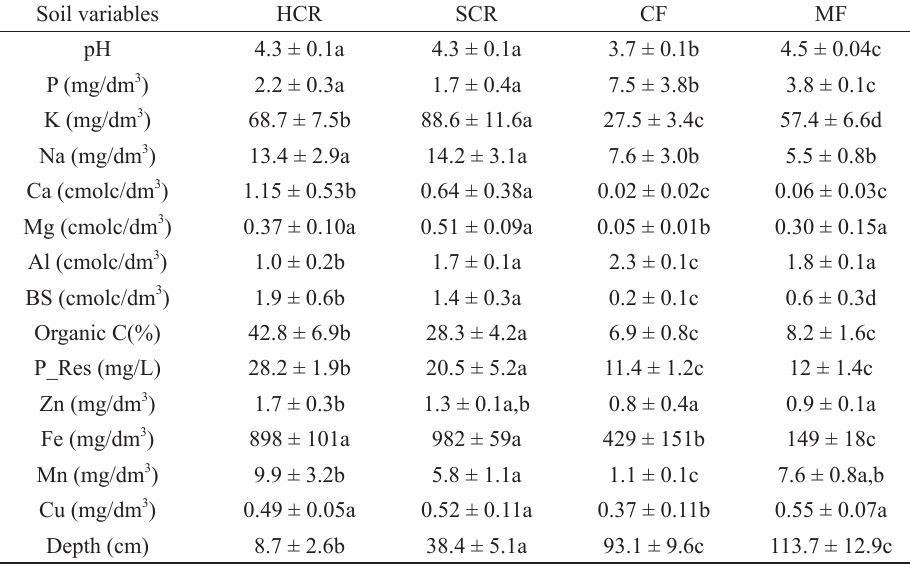
Mean soil variable concentrations (±95% C.I.) for surface soils .0–10 cm. by vegetation type on lateritic canga at Serra Sul, Serra dos Carajás, state of Pará, Brazil. SCR = shrubby campo rupestre; HCR = herbaceous campo rupestre; CF = capão forest; MF = montane forest. Row values (vegetation groups) followed by the same letter are not significantly different (ANOVA with post–hoc Tukeys test;